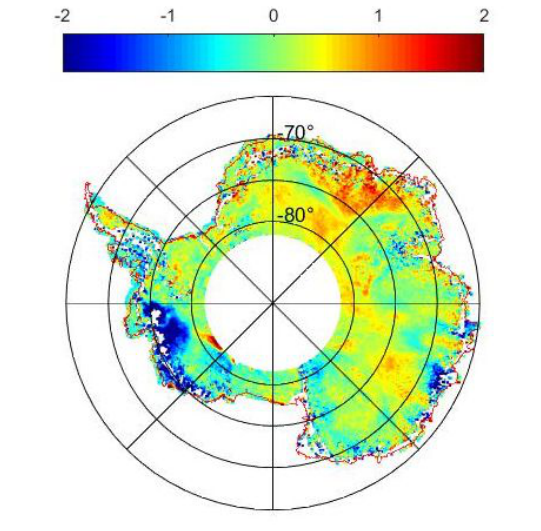
Figure 22. Difference (in m) between Ka and Ku-band height from the Envisat and SARAL/AltiKa altimeter over Antarctica. Due to the difference of penetration, in the central part, the Ku-band elevation is indeed below the Ka one. Near the coast, the smaller antenna aperture of Ka-band yields to a smaller slope error. In the West Antarctica sector, the negative pattern is due to the decrease of surface topography between the time of Envisat and of SARAL/AltiKa